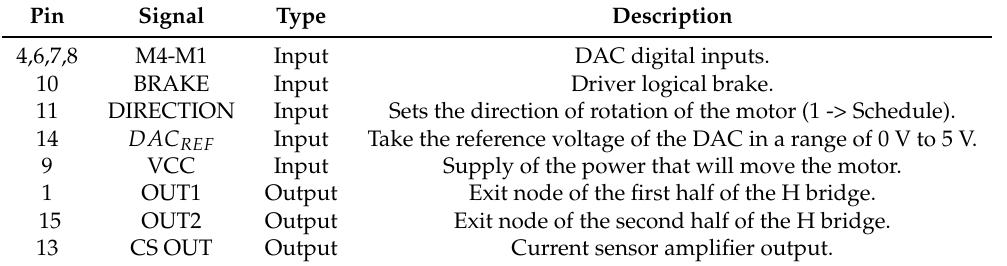
Figure A5. Graphic interface in MatLab. Table A3. Relevant sign